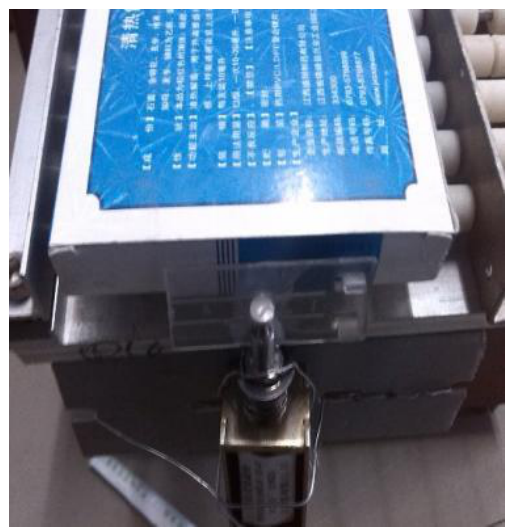
Figure 6. Experimental diagram.